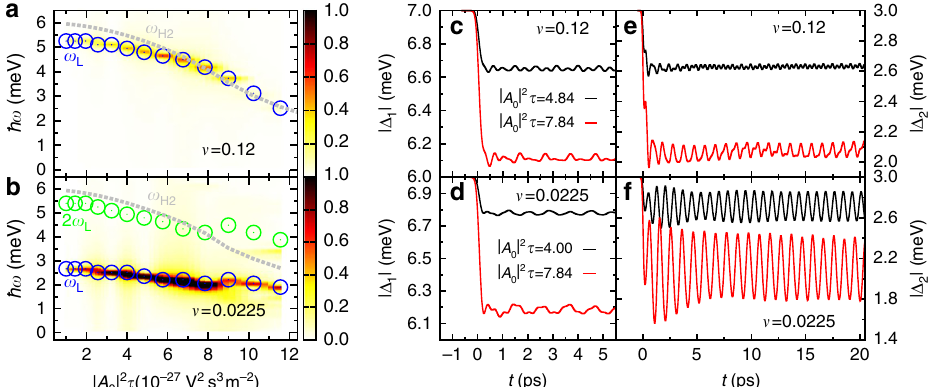
Figure 5 | Fluence dependence of gap dynamics. ( a , b ) Fourier spectrum of the phase mode F 1 – F 2 as a function of laser fluence (integrated pulse intensity) | A 0 | 2 t for two different interband couplings u with pulse energy : o 0 ¼ 8meVand pulse width t ¼ 0.4ps. The amplitude of the phase fluctuations is represented by the colour scale with dark red and light yellow indicating high and low amplitudes, respectively. The open circles mark the frequencies of the non-equilibrium Leggett mode o L and its higher harmonic 2 o L . The grey dotted lines display the Higgs mode o H2 , which coincides with the boundary to the continuum of Bogoliubov quasiparticle excitations. ( c – f ) Gap amplitudes | D 1 | and | D 2 | as a function of time t for two different interband couplings v and integrated pulse intensities | A 0 | 2 t